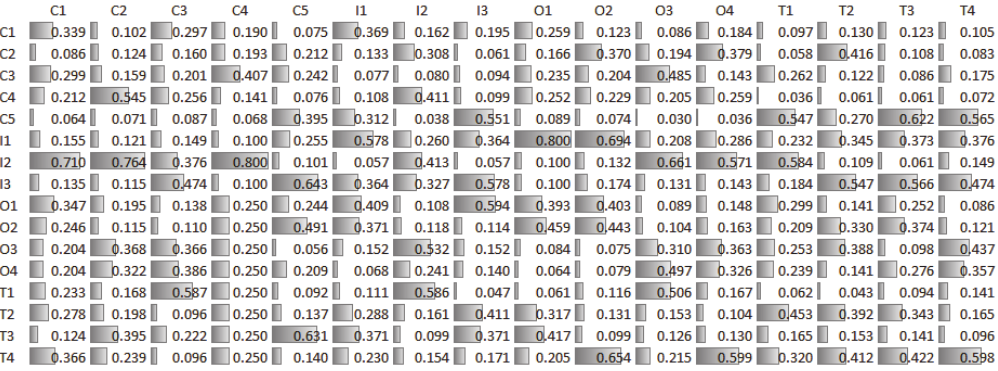
Fig. 5. Unweighted Super Matrix of the Port Community.